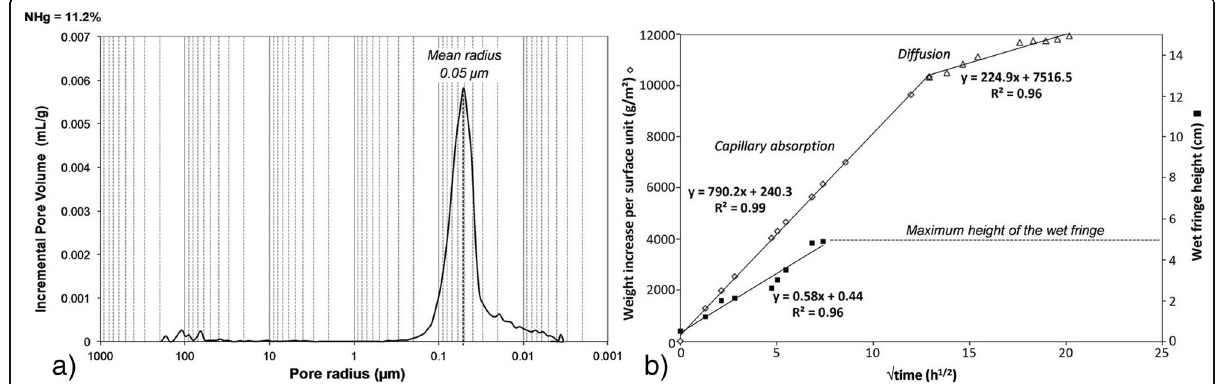
Fig. 2 a Pore distribution obtained by mercury injection porosimetry and b capillary kinetics of the Courville limestone “ Banc Roche ”